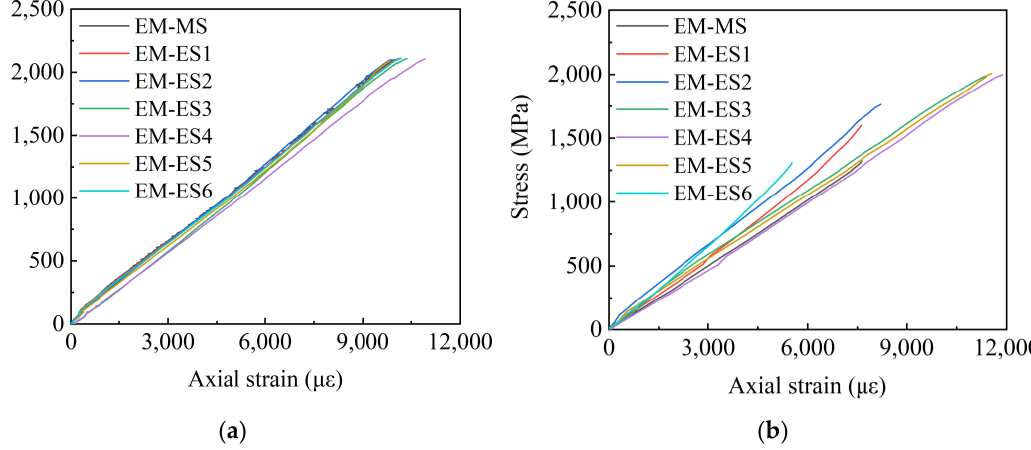
Figure 15. EM-X group stress–strain curve. ( a ) EM-1 stress–strain curve; ( b ) EM-2 stress–strain curve.